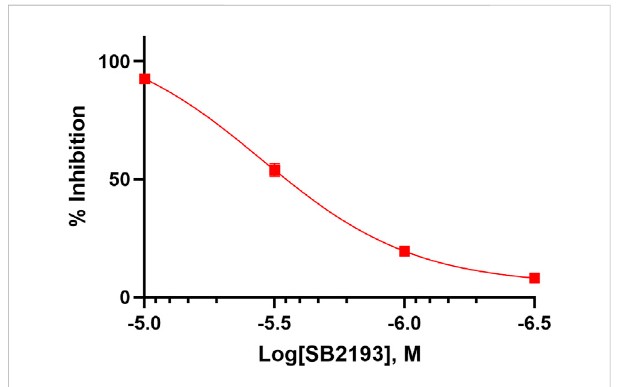
FIGURE 3 SB2193 inhibited Ca v 3.1 in whole-cell patch-clamp electrophysiology experiments ( n = 7 – 8). Data are expressed as mean±SEMandcurvesrepresent fi